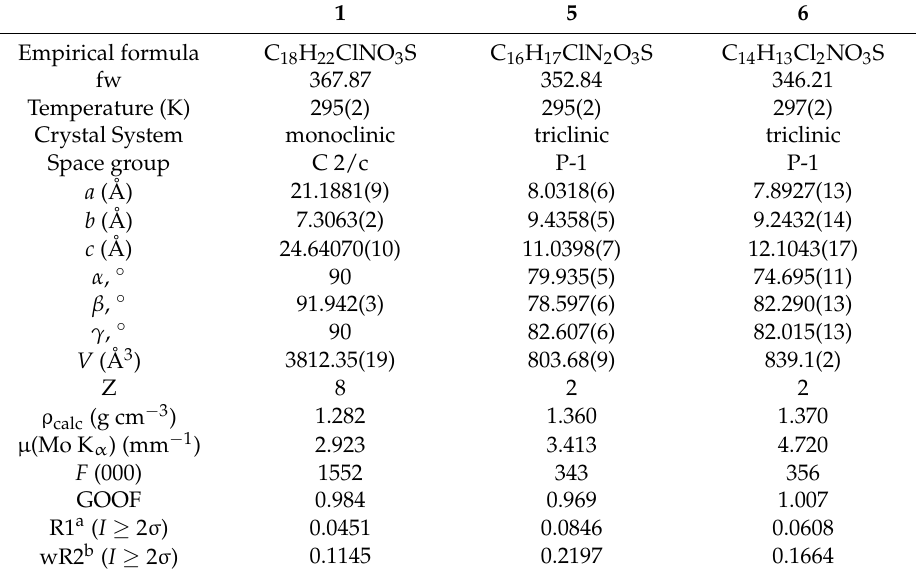
Table 1. Crystallographic data and structure refinement details for 1 , 5 , and 6